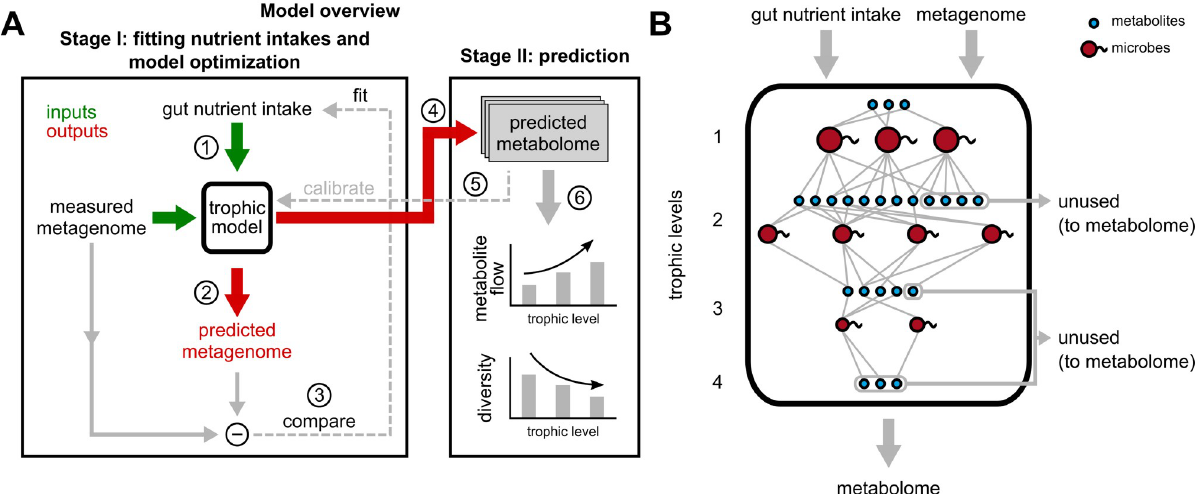
Fig 1. Overview of the trophic model, its calibration and predictions. (A) Schematic diagram showing the various steps in the trophic model, which uses fits the gut nutrient intake profile best approximating the measured metagenome, and outputs a predicted metagenome (microbial abundances) and metabolome. The experimentally measured metabolome is used to calibrate the number of trophic levels, N ℓ and byproduct fraction, f of the model. (B) “Zoomed-in” view of the trophic model from (A), with different microbial species (red) and metabolites (blue) spread across the four trophic levels suggested by the model. At each level, metabolites are consumed by microbial species, and converted partially to their biomass, while the remainder is secreted as metabolic byproducts, which are nutrients for the next trophic level. Metabolites that are left unconsumed across each level are assumed to eventually exit the gut as part of the fecal metabolome, while the biomass accumulated by each species across all levels contributes to the metagenome.